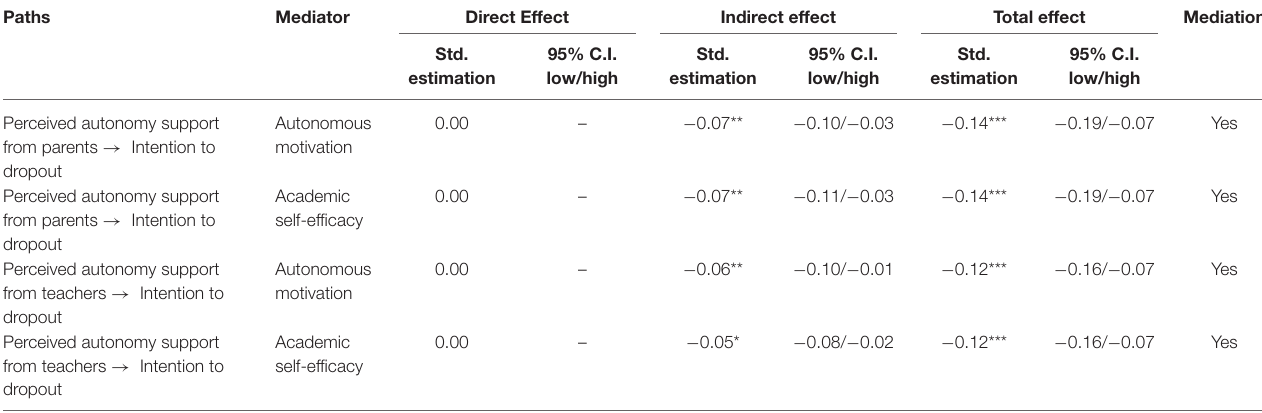
TABLE 4 | Standardized path coefficients for mediated effects for the structural equation model for academic adjustment.